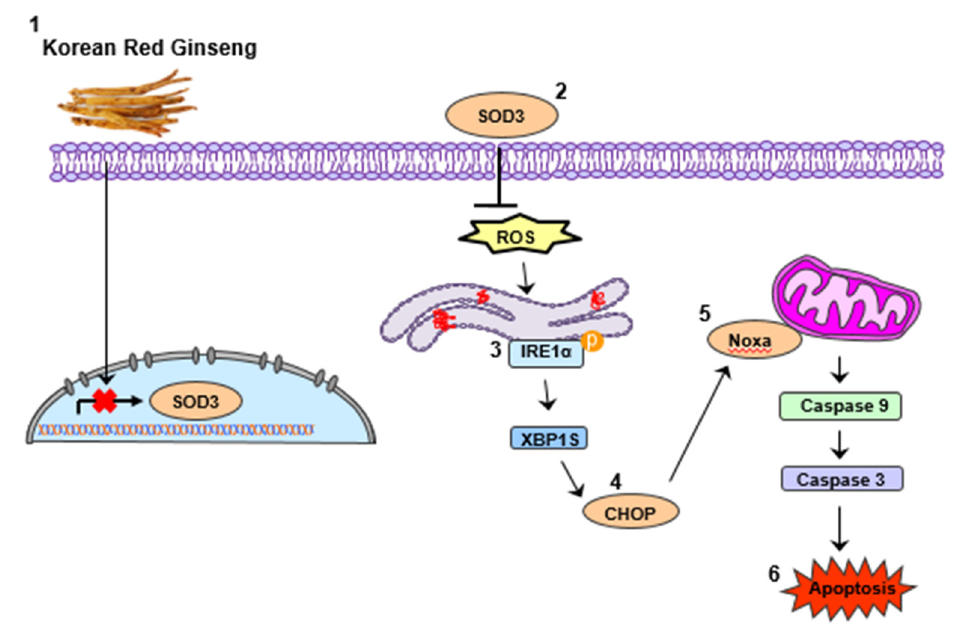
Figure 5. Schematic diagram for apoptosis induced by KRG extract.